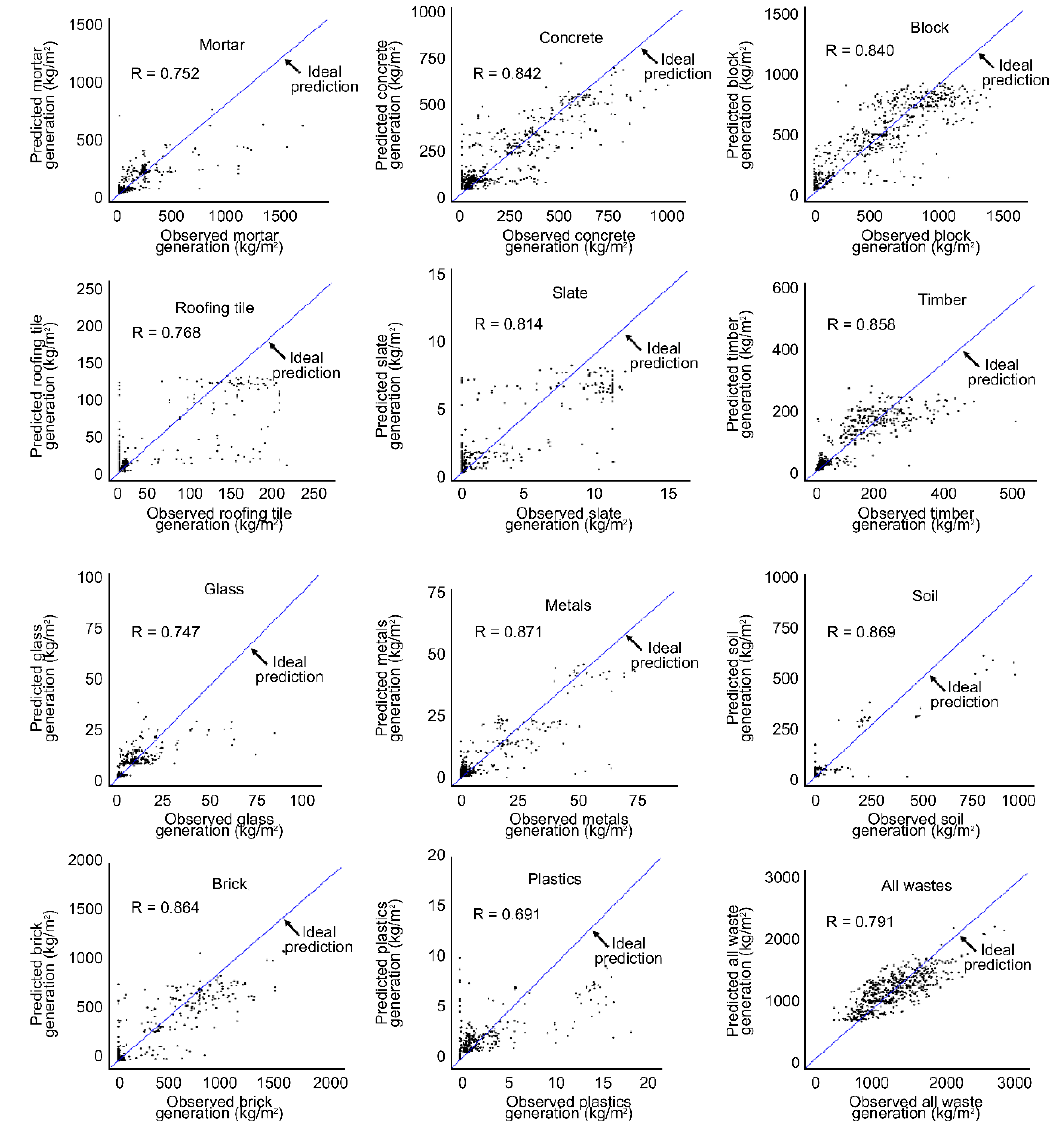
Figure 4 Performance of the RT model for demolition waste generation prediction. Figure 4. Performance of the RT model for demolition waste generation